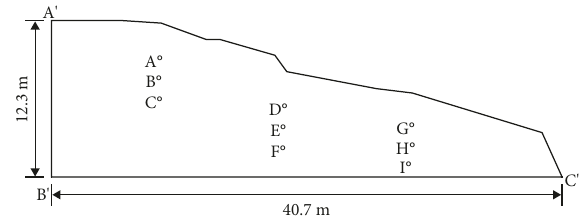
Figure 1: Computational model section.